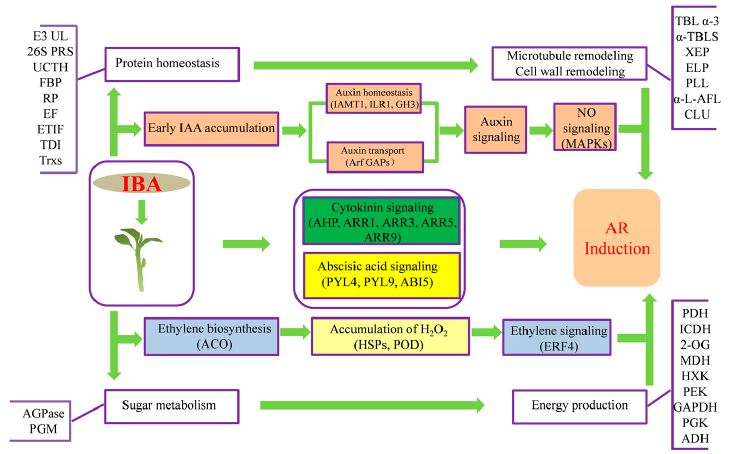
Figure 6. Model of the AR induction pathway in ‘T337’ basal cuttings. After the supplement of exogenous IBA, proteins related to auxin homeostasis and transport facilitated the auxin accumulation in apple, which promoted auxin signaling, as well as nitric oxide signaling. Enhanced ethylene biosynthesis promoted H 2 O 2 accumulation and ethylene signaling. Meanwhile, cytokinin signal was reduced and abscisic acid signal was enhanced. Sugar metabolism and energy production proteins ensured adequate carbon skeleton and energy supply. Protein homeostasis proteins, especially proteins related to ubiquitinylation might participate in adventitious roots (ARs) formation through the regulation of phytohormone signaling. In addition, microtubule proteins, along with proteins related to cell wall properties, functioned in the shift from cell division to cell differentiation to stimulate AR formation instead of callus formation. IAMT, Indole-3-acetate O -methyltransferase 1; ILR1, IAA-amino acid hydrolase; GH3, Indole-3-acetic acid-amido synthetase; Arf GAPs, ADP-ribosylation factor GTPase-activating protein; AHP, Histidine-containing phosphotransfer protein; ARRs, two-component response regulators; PYL9, Abscisic acid receptor PYL9; PYL4, Abscisic acid receptor PYL4; ABI5, ABSCISIC ACID-INSENSITIVE 5-like protein; ACO, 1-aminocyclopropane-1-carboxylate oxidases; HSPs, Heat shock 70 kDa protein; POD, Peroxidase; MAPK, Mitogen-activated protein kinase; ERF4, Ethylene-responsive transcription factor 4; E3 UL, E3 ubiquitin ligase; 26S PRS, 26S proteasome regulatory subunits; UCTH, Ubiquitin C-terminal hydrolases; FBP, F-box protein; RP, Ribosomal protein; EF, Elongation factor; ETIF, Eukaryotic translation initiation factor; TDI, Thiol-disulfide isomerase; Trxs, Thioredoxins; TBL α -3, Tubulin alpha-3; α -TBLS, Alpha-tubulin suppressor; XEP, Xyloglucan endotransglucosylase protein; ELP, Expansin-like protein; PLL, Pectin lyase-like superfamily protein; α - L -AFL, α - L -arabinofuranosidase; CLU, Cellulase; AGPase, ADP- glucose pyrophosphorylase; PGM, phosphoglucomutase; PDH, Pyruvate dehydrogenase; ICDH, Isocitrate dehydrogenase; 2-OG, 2-oxoglutarate; MDH, malic enzyme; HXK, Hexokinase; PEK, 6-